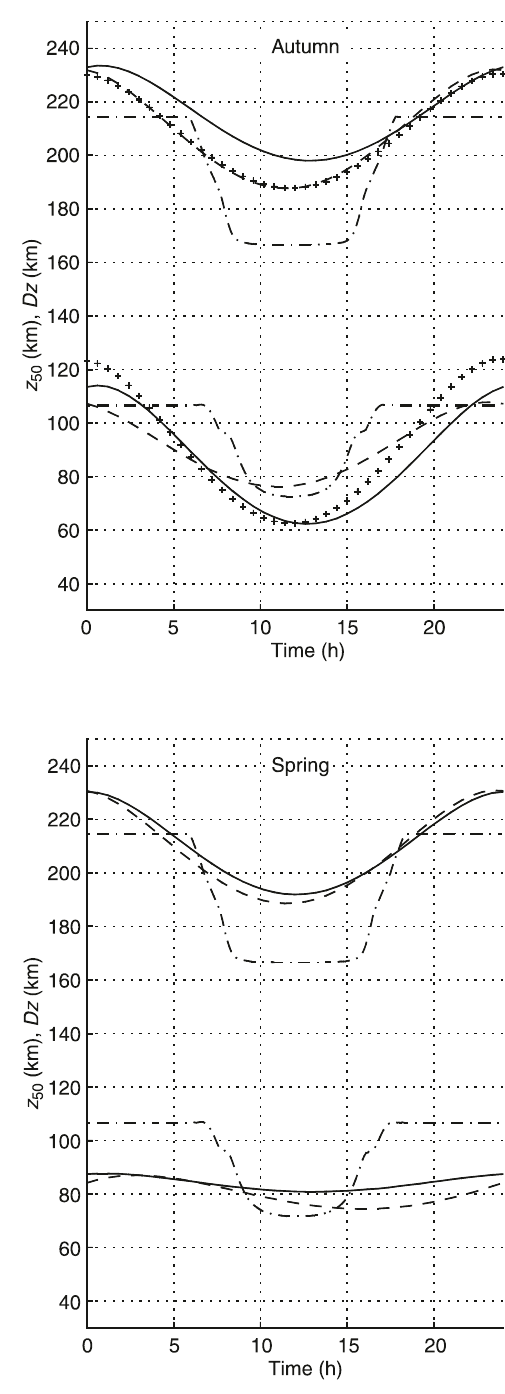
Fig. 5. The results of fitting for various seasons and high ( dashed line ) and low ( continuous line ) solar activity are shown. The crossed line corresponds to Lathuille` re and Pibaret’s model (there is no model for